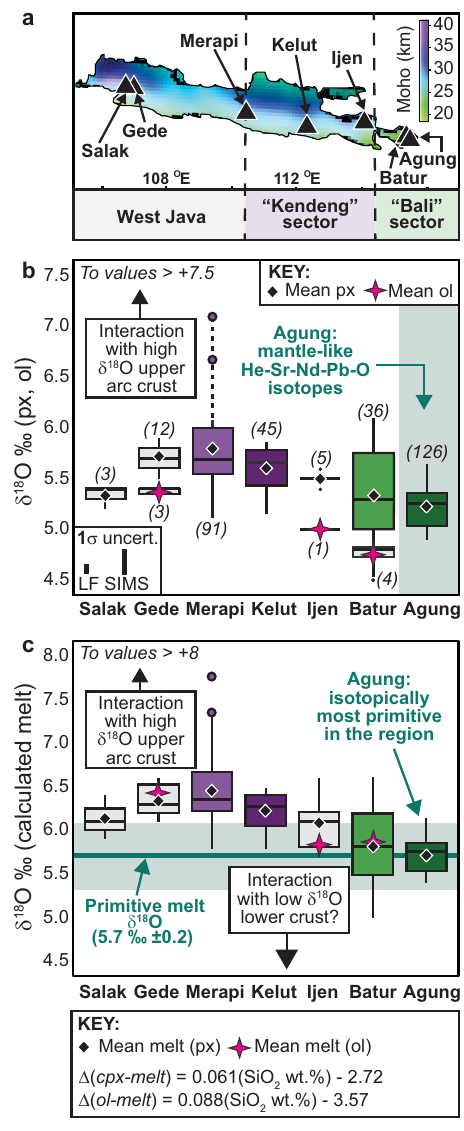
Fig. 4 Arc-wide compilation of δ 18O values in ma fi c minerals and equilibrium melts. a Map of Java and Bali showing Moho depths estimated from Bouguer gravity anomalies (after ref. 40 ). The Moho lies at ca. 18-20 km beneath Bali compared to ca. 25-30 km beneath Central to East Java. b Box-and-whisker plots of pyroxene and olivine δ 18 O values from volcanoes along the Java-Bali segment of the Sunda arc, showing grain averaged SIMS clinopyroxene data for Merapi, Kelut, Batur, and Agung (dark grey), pyroxene LF data for Salak 36 , Gede 30 , and Ijen 37 , and olivine LF data for Gede 30 , Ijen 37 , and Batur (ref. 14 and this study). The number of analyses per volcano are given in parentheses. c Box-and-whisker plots of equilibrium melt δ 18 O values calculated for the mineral data shown in panel b by employing the silica-dependent fractionation formulations of ref. 24 . The clinopyroxene data suggest a parental melt δ 18 O value of 5.7 ‰ (±0.2 1sd) for the Sunda arc. For most Javanese volcanoes, magmas are stored in the arc crust where they evolve while assimilating crustal materials, resulting in variably elevated δ 18 O values in clinopyroxene. Data plotting